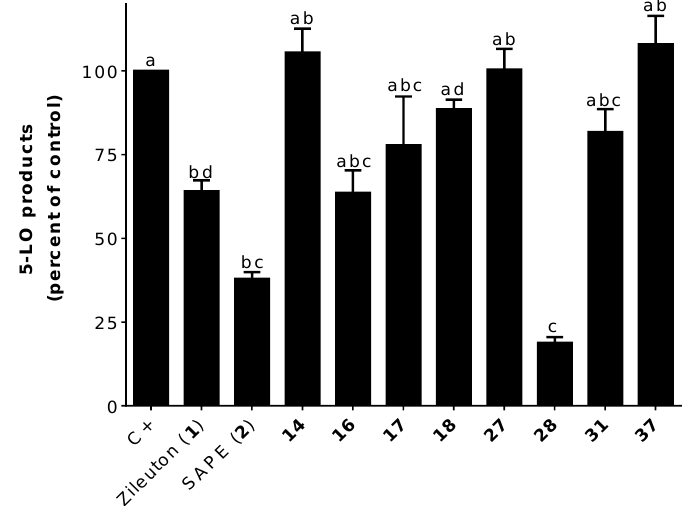
Figure 6. Inhibition of the biosynthesis of 5-LO products in human polymorphonuclear leukocyte (PMNL) cells by zileuton ( 1 ; 1 μM), SAPE ( 2 ; 1 μM), 14 , 16-18, 27-28 , 31, and 37 (1 μM). Data are expressed as means ± SEM of at least three independent experiments. Values without one common superscript (a, b, c, or d) are significantly different determined by one-way ANOVA with Tukey’s multiple comparison test ( p < 0.05).